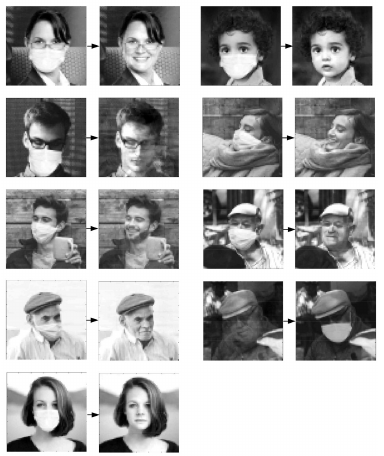
Figure 4. Reconstruction of face images of people wearing